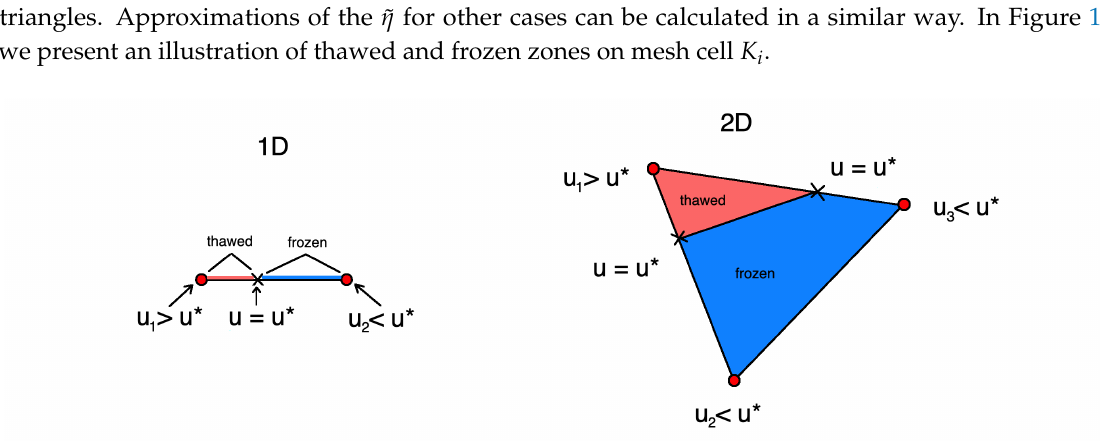
Figure 1. Illustration of unfrozen water concentration η in mesh cell K i . Left : one-dimensional formulation (1D). Right : two-dimensional formulation